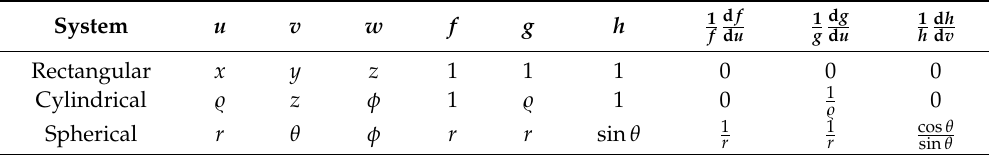
Table 1. Coordinates, metric functions, and metric derivatives for common curvilinear coordinate